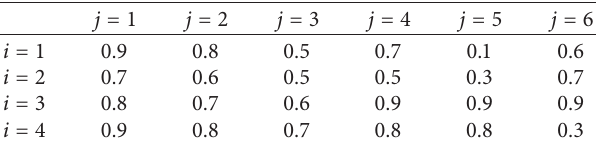
Table 6: Skill level.